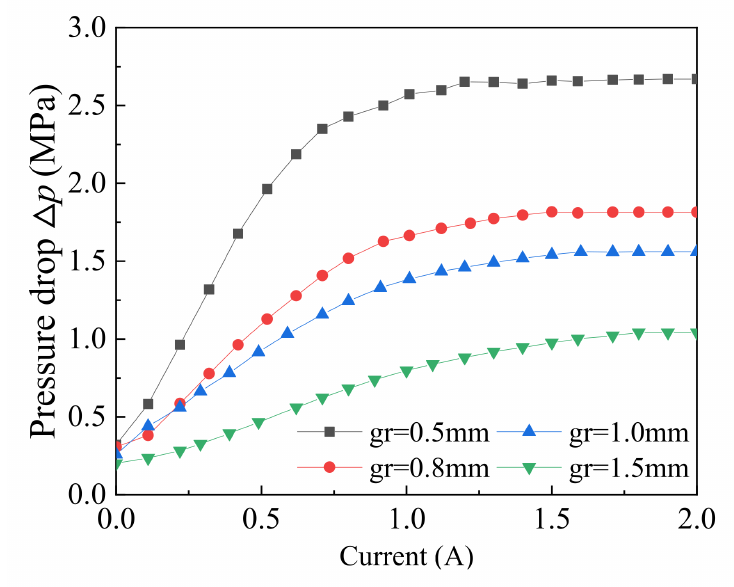
Figure 11. Variation of pressure drop with current under four radial